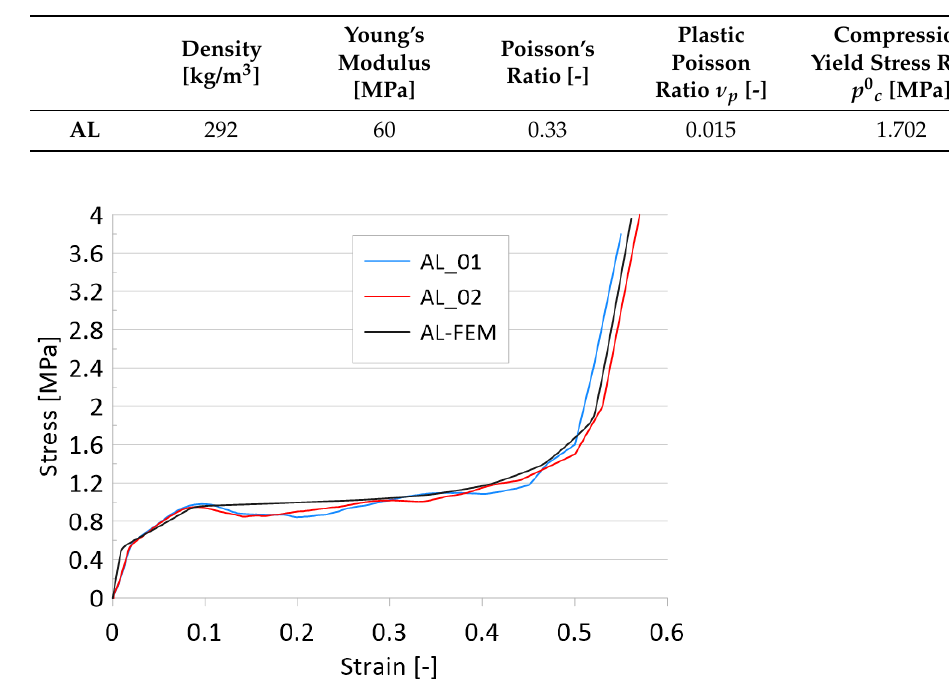
Table 2. Basic parameters of ALPORAS aluminum foam [37].